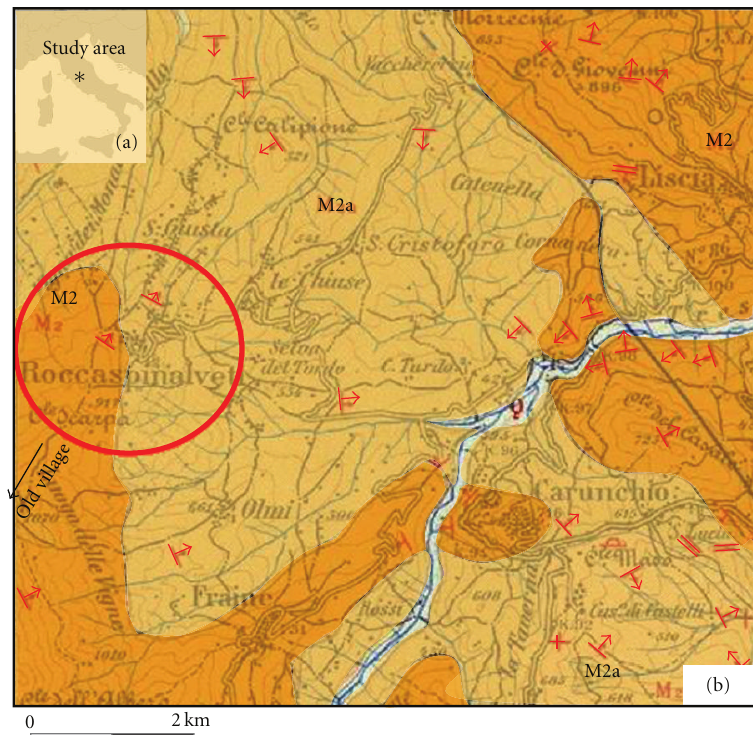
Figure 1: Study area location (a). The geological map (b) shows two outcropping formations Miocene in age: a flysch complex formed by a succession of calcareous sandstone, dense marl, clayey-marl-clay strata (M2), and a complex formed by a succession of clayey-sand and marl strata (M2a). The red arrows indicate the faults and the black arrow indicates the location of the old village 3km from the present